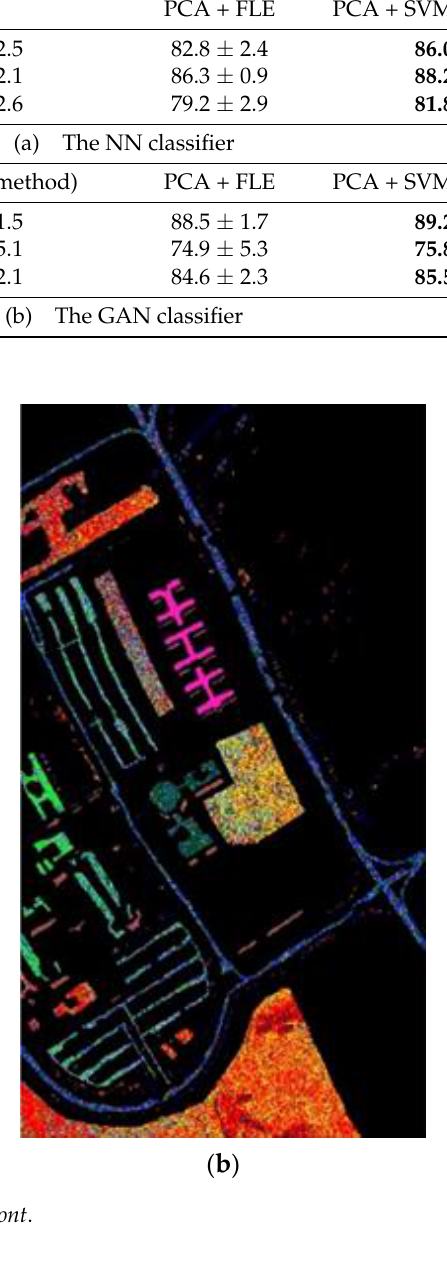
Table 6. The classification results on dataset Pavia University.